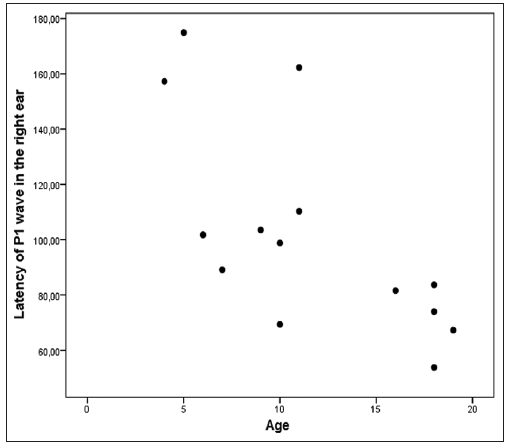
FIGURE 1. Scatter plot considering age versus latency of P1 wave in the right ear.